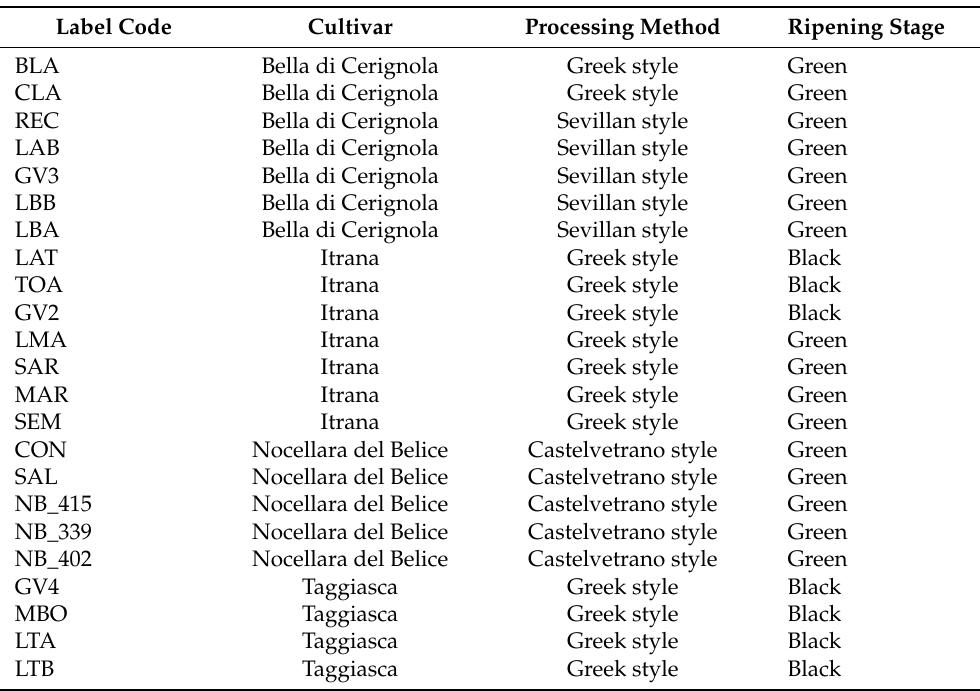
Table 1. Labelling, processing methods and ripening stages of the twenty-three samples distinguished by